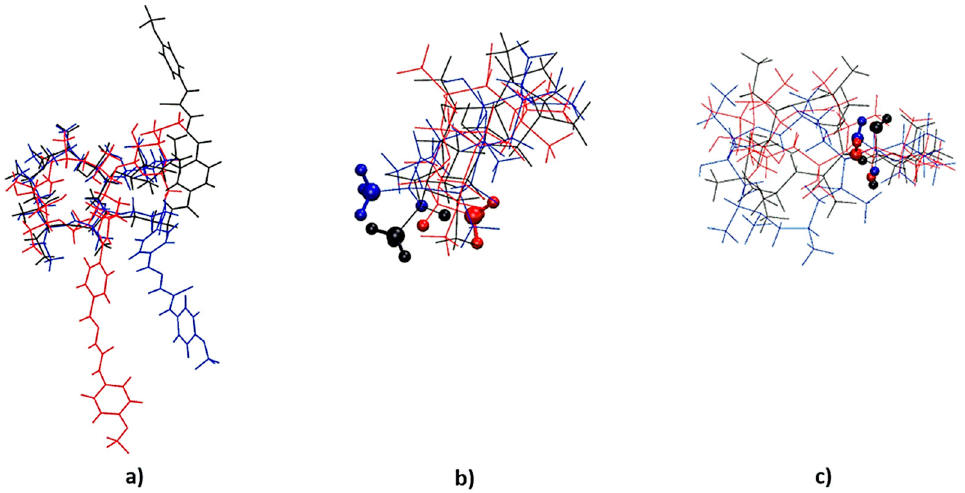
Figure 8. ( a ) The overlapped conformations of 3a (black), 3a-5 (red) and 3a-6 (blue), ( b ) highlighted configurations at C-2 and ( c ) highlighted configurations at C-1 ′ . Table 1. Relative configurations at atoms C-2, C-1 ′ and C-2 ′ of bioactive macrozone stereoisomers.